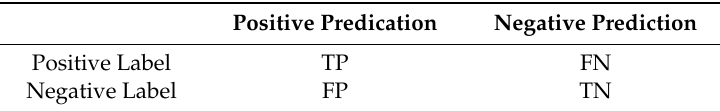
Table 1. Four categories of the